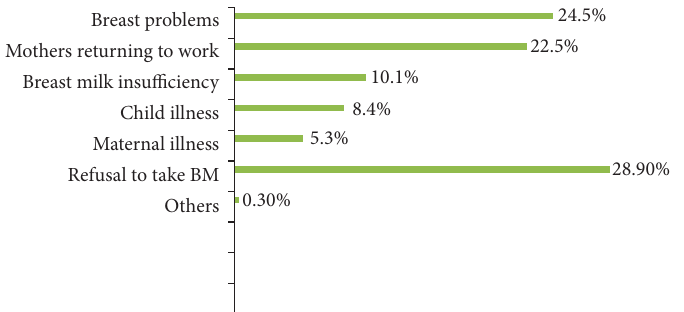
Figure 1: Reasons for not to breastfeed infants among mothers in Debre Tabor town, Northwest Ethiopia in Debre Tabor town, Northwest Ethiopia.